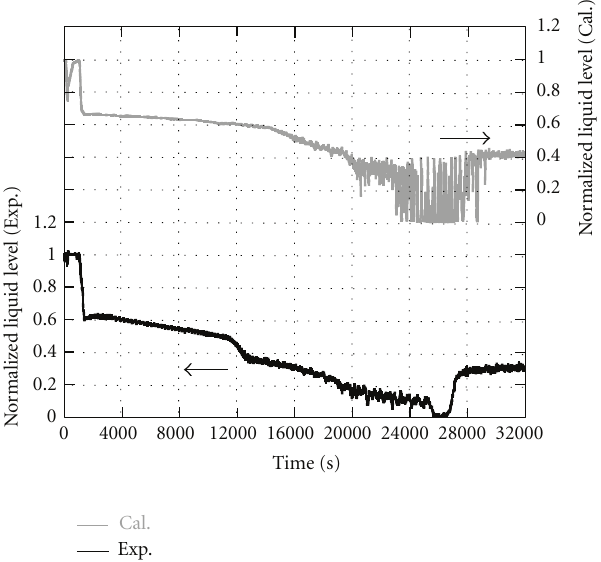
Figure 21: LSTF and RELAP5 results for upper plenum collapsed liquid